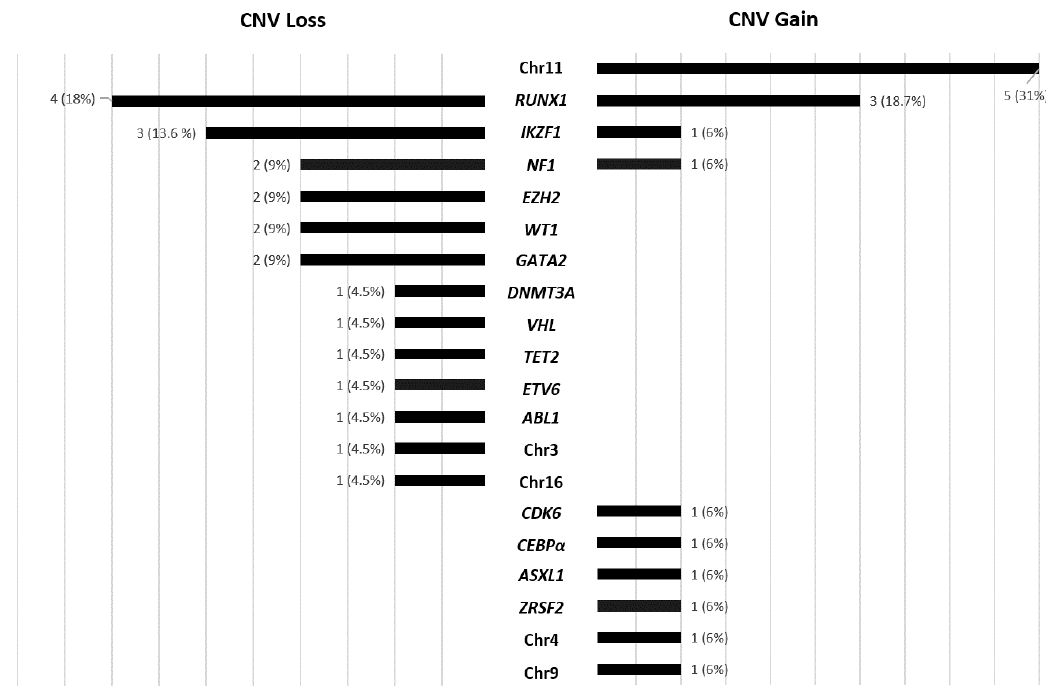
Figure 2. Secondary CNV gains and losses involving genes included in the panel for mutational status analysis: chr11, chr3, chr16, chr4 and chr9 represented CNV gain or loss in all the genes included for these chromosomes.